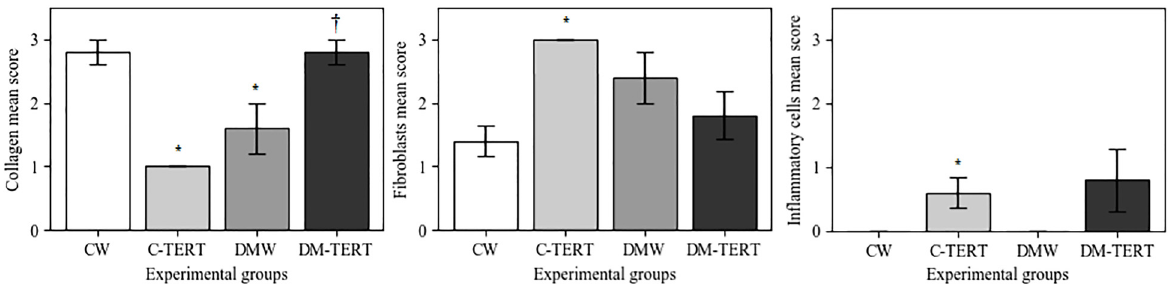
Figure 5. Score analysis of collagen ( A ), fi broblasts ( B ), and in fl ammatory cells ( C ) of skin wounds after treatment with human bone marrow mesenchymal stem cells immortalized by the expression of telomerase (hBMSC-TERT). Data are reported as means ± SD for n=6 – 10 rats/group. *P o 0.05 vs CW; w P o 0.05 vs DMW (ANOVA). CW: control rats wounded; C-TERT: non-diabetic rats wounded and infused with hBMSC-TERT; DMW: diabetic rats wounded; DM-TERT: diabetic rats wounded and infused with